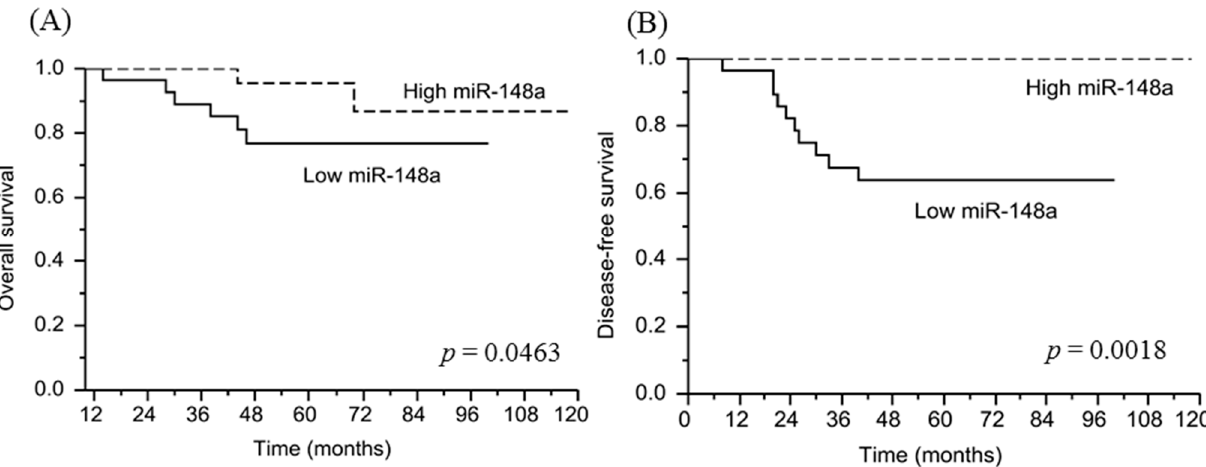
Figure 8. Survival curves of the 51 patients. ( A ) Overall survival in patients with low miRNA-148a expression was significantly poorer than that in those with miRNA-148a overexpression ( p = 0.0463). ( B ) Disease-free survival in patients with low miRNA-148a expression was significantly shorter than that in patients with miRNA-148a overexpression ( p = 0.0018).